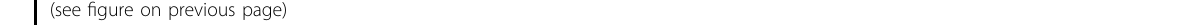
Fig. 1 Identi fi cation of bi-allelic variants of WDR63 in patients with MMAF. a , b Pedigree of family 1 affected by bi-allelic WDR63 variant that was identi fi ed by WES from MMAF-affected men (a). Pedigree of family 2 affected by bi-allelic WDR63 variant that were identi fi ed by Sanger sequencing from NOA-affected men (b). Filled black fi lled squares indicate infertile men in this family. Sanger sequencing results are shown under the pedigrees. The mutated positions are indicated by red arrows. c Schematic representation of the domains of WDR63 and locations of WDR63 variants identi fi ed in this study. Sequence alignment shows conservation of the mutated residues across different species according to UCSC genome browser. The green boxes indicate Trp-Asp (WD40) repeat domains as described by the UniProt server. d WDR63 variants cause the degradation of WDR63 protein. Full-length wild-type and mutant WDR63 cDNA constructs were overexpressed in HEK293T cells followed by immunoblotting analysis. Abbreviations: M1, mutation 1; M2, mutation 2; Homo, homozygous; WD40, Trp-Asp repeat.